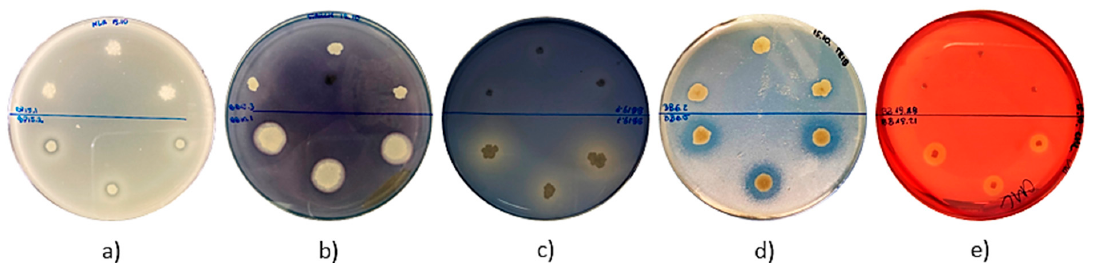
Figure 3. Enzymatic activity of isolates. Selected agar plates are presented with observed ( a ) proteolytic, ( b ) amylolytic, ( c ) lipolytic, ( d ) esterolytic, and ( e ) cellulolytic activity. In the upper part of the plates, there are strains that did not exhibit enzymatic activity, while in the lower part of the plates, there are strains capable of producing hydrolases.